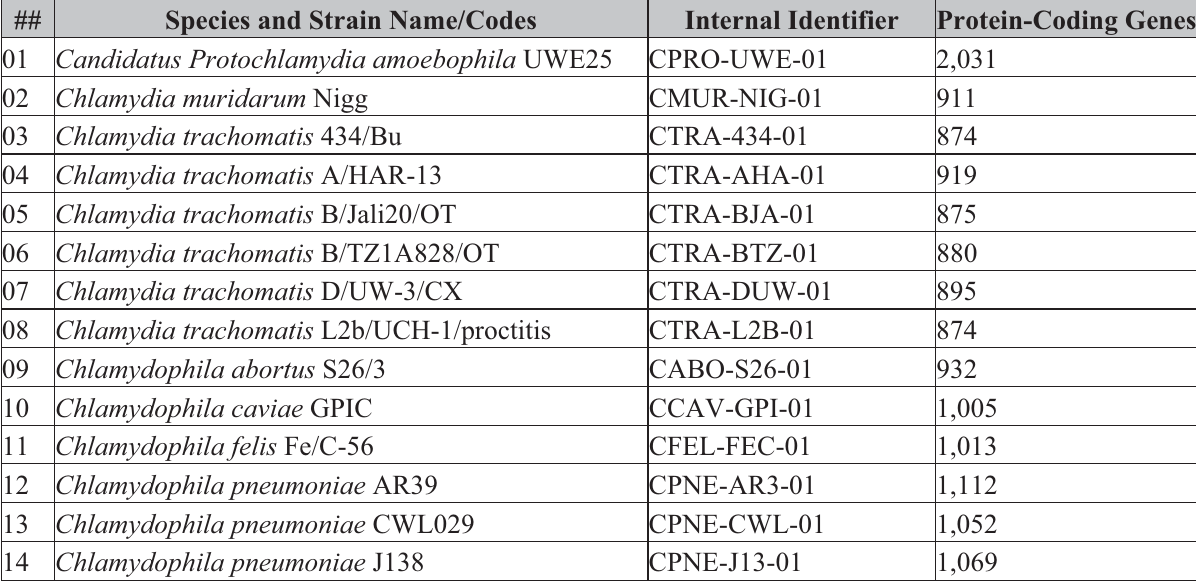
Table 1. List of Chlamydiales genome sequences used in this